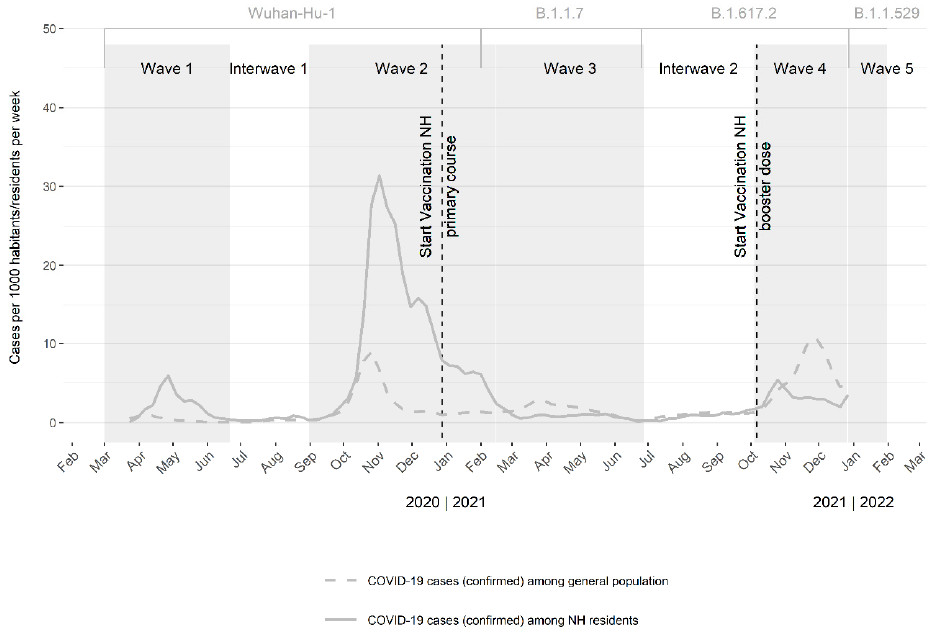
Figure 1. Confirmed cases per 1,000 nursing home (NH) residents and per 1,000 inhabitants, per week, in Belgium. A two ‐ week moving average is presented from 17 March 2020–2 January 2022. The nursing home residents are included in the confirmed cases among the general population. Grey boxes indicate the COVID ‐ 19 (coronavirus disease 2019) waves. Grey brackets indicate the dominant variant. The dotted lines indicate the COVID ‐ 19 vaccination campaign (primary course) and the booster administration in nursing homes. Wuhan ‐ Hu ‐ 1: Severe acute respiratory syndrome coronavirus 2 (wild type); B.1.1.7: Alpha variant; B.1.617.2: Delta variant; B.1.1.529: Omicron variant; NH: nursing home. 2.4. Population Nursing home residents included in this surveillance were persons at least staying more than one night in the institution. Nursing home staff are all personnel working in the facility (nursing staff, paramedical staff, animation team, staff concerned with clean ‐ ing, maintenance or quality control and long ‐ term care facility managers and their admin ‐ istrative staff), not including staff who are absent for longer than one month, volunteers and students. 2.5. Data Processing, Analysis and Validation The COVID ‐ 19 surveillance in Belgian NHs was organized by the regional health au ‐ thorities. The raw data of all regions were merged in one database and analysed at na ‐ tional level by Sciensano, the Belgian institute for health [1,3]. More details of the different regional data collection tools and methods can be found in Vandael et al. [1] and Renard et al. [3]. The data extraction process and the data cleaning were automated as much as possible in SAS Enterprise Guide version 7.1. to avoid manual mistakes. More information about the automatic data cleaning and the used validation rules can be found in Vandael et al. [1]. The definitions applied to calculate possible clusters are presented in Table 1.